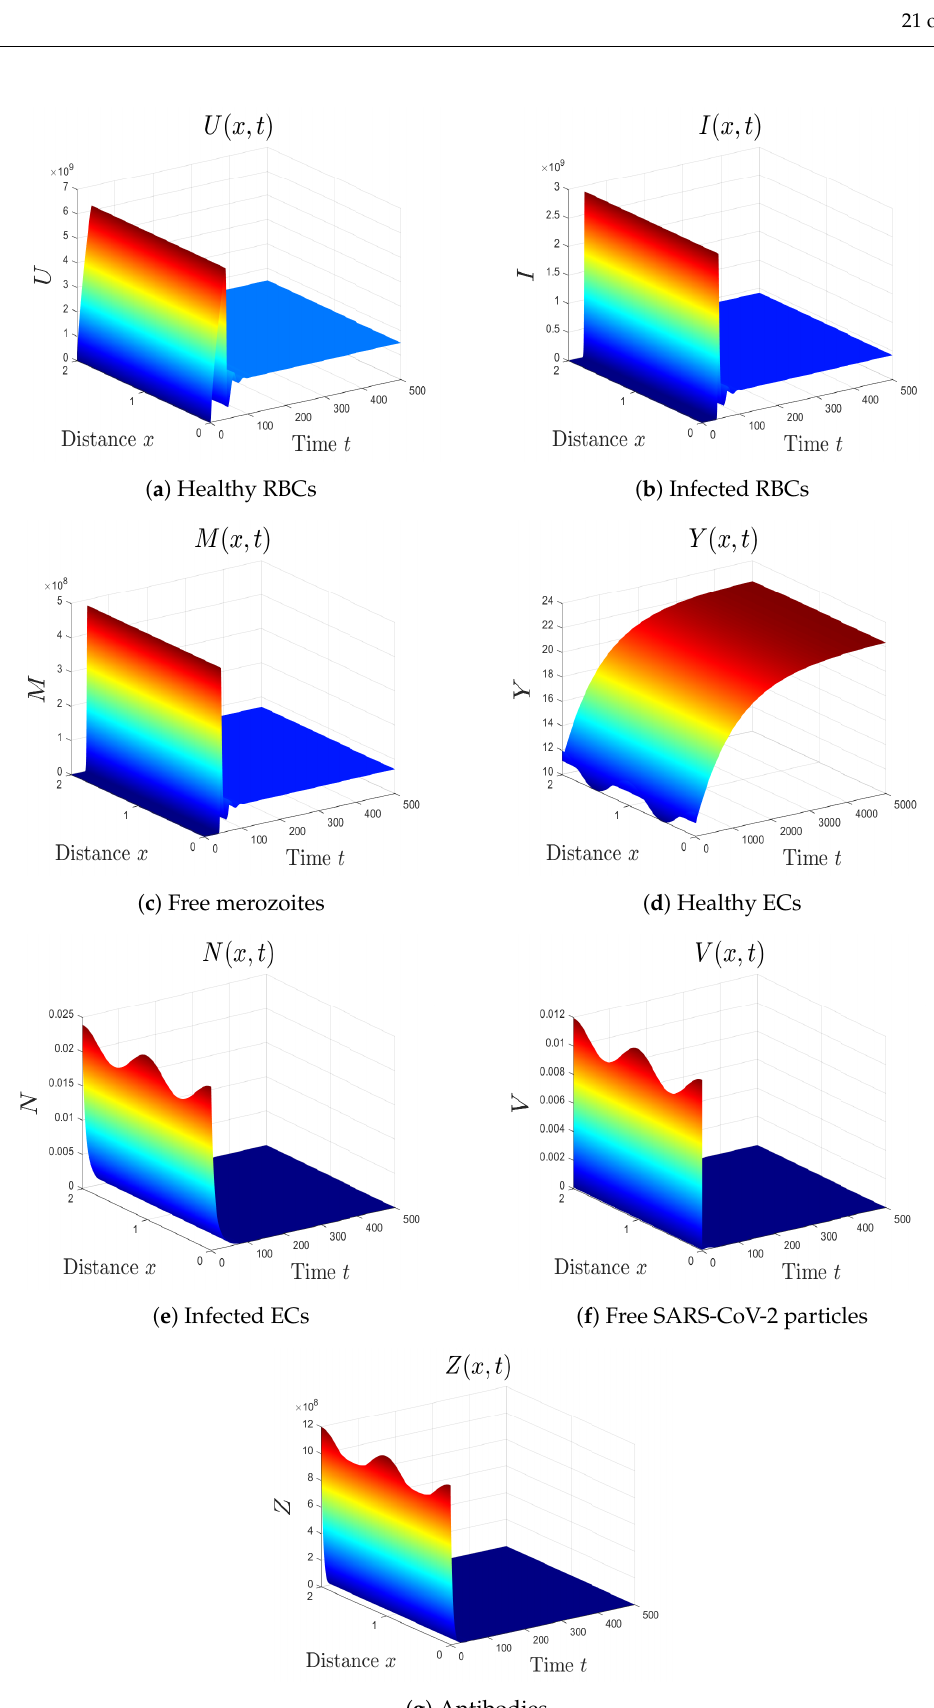
Figure 2. Simulation of system (1) for ( β m , β v , p 1 , p 2 , d 7 ) = ( 2 × 10 − 9 ,0.1,2 × 10 − 9 ,0.96,0.2 ) . The equilibrium E 1 = ( 1.5 × 10 9 ,4.25 × 10 8 ,7.08 × 10 7 ,22.41,0,0,0 ) is